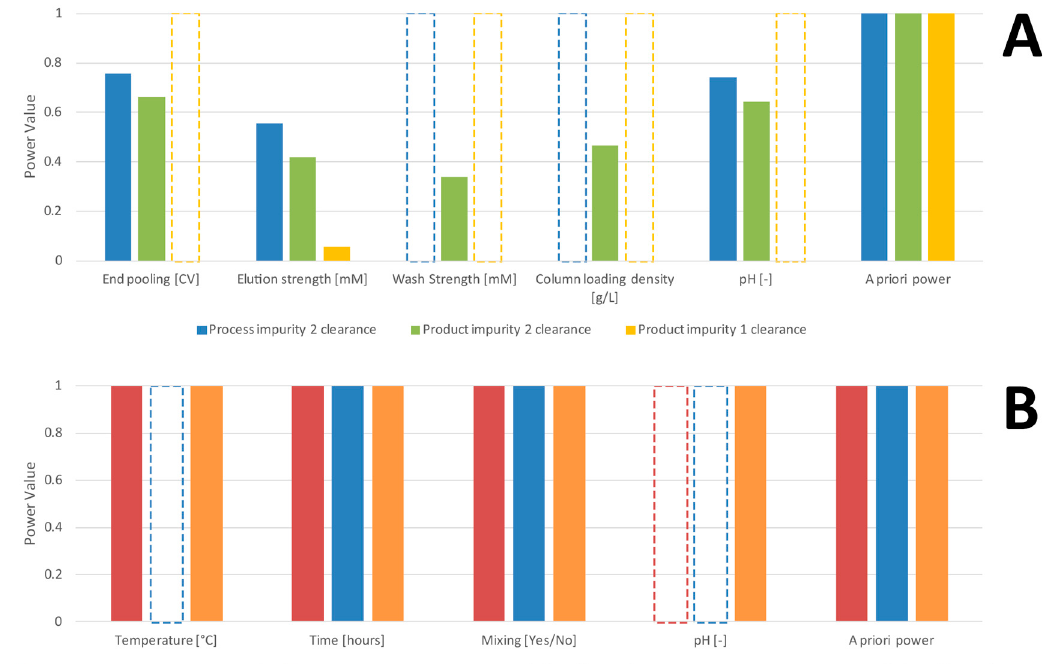
Figure 1. Power values for chromatographic column (CC) 1 ( A ) and PR ( B ) for each process parameter (PP) and CQA. Where significant process parameters were detected for a quality attribute, bars are marked grey. ( A ) Though a priori power analysis suggested a power of 100% for each investigated CQA for chromatography step 1, retrospective power analysis revealed that the power to detect a critical effect did not surpass 80% for any of the investigated process parameters. Strategies to tackle these low-power-situations are given in Figure 4. ( B ) For the precipitation step, a priori power analysis suggested a power of 100% for each investigated CQA as well. Retrospective power confirmed the findings that there is a 100% chance that we did not overlook a critical effect of the investigated process parameters on quality attributes.